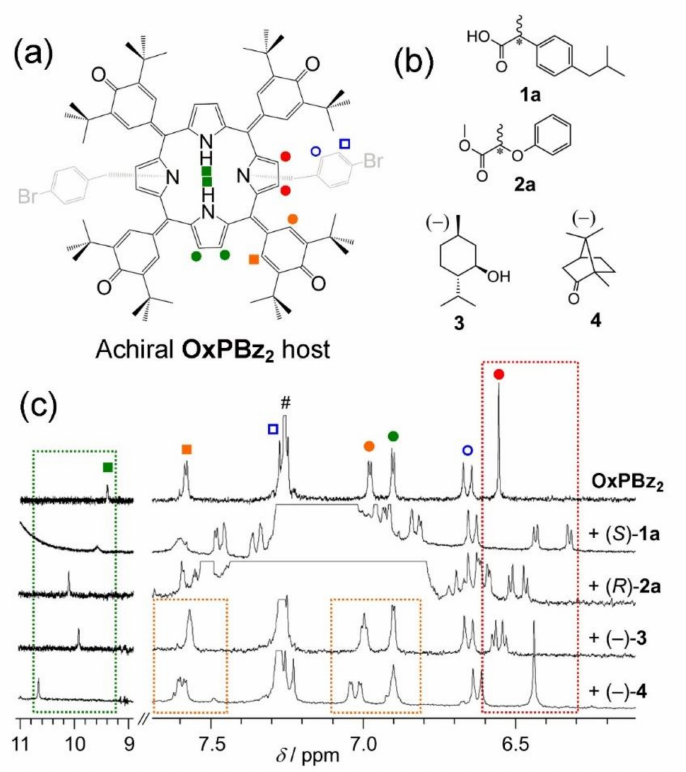
Figure 6. ( a ) Structure of the achiral host OxPBz 2 . Colored shapes denote the proton resonances in (c). ( b ) Selected chiral guests. Ibuprofen ( 1a ), 2-phenoxypropionic acid methyl ester ( 2a ), ( − )-menthol (( − )- 3 ), ( − )-camphor (( − )- 4 ). (c) 1 H NMR spectra of OxPBz 2 (CDCl 3 , 0.7 m M ) with ca. 400 eq. of the chiral guests indicated. Adapted with permission from ref. [43]. Copyright 2013 Labuta et